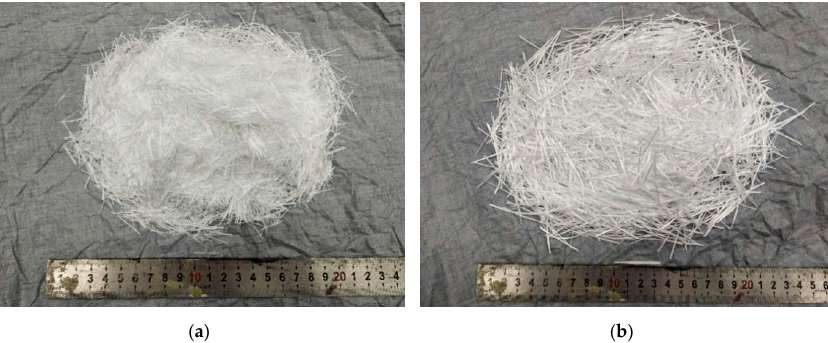
Figure 2. Size distributions of coral aggregates.